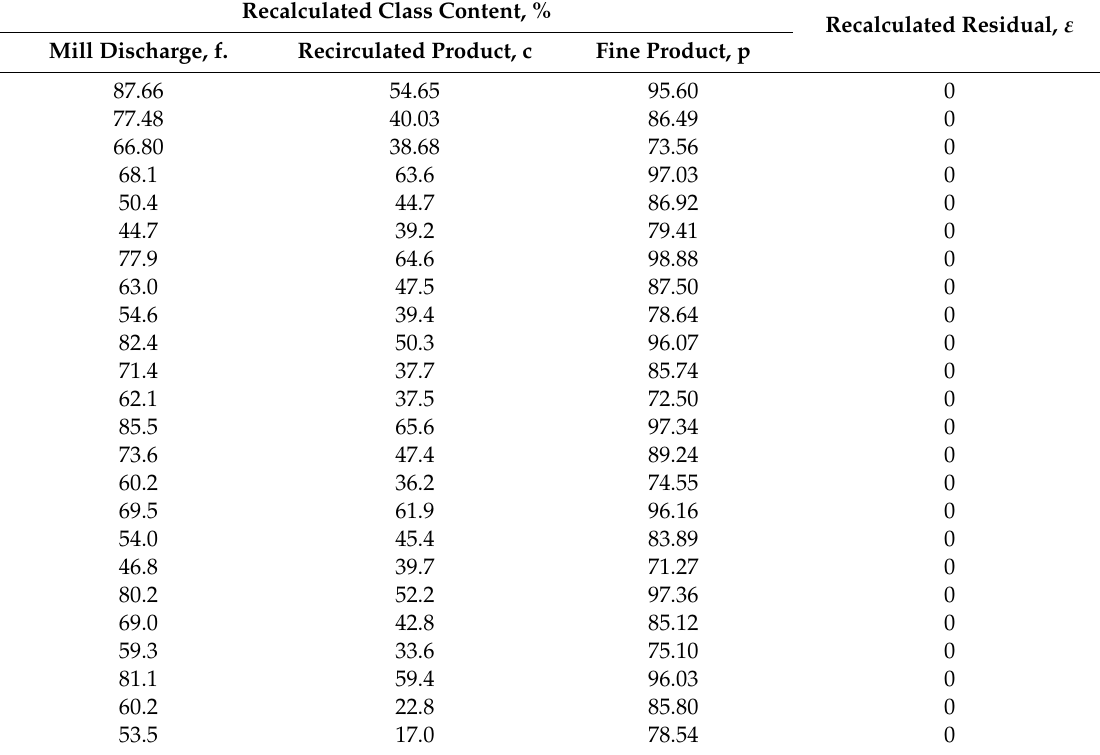
Recalculated Residual, ε